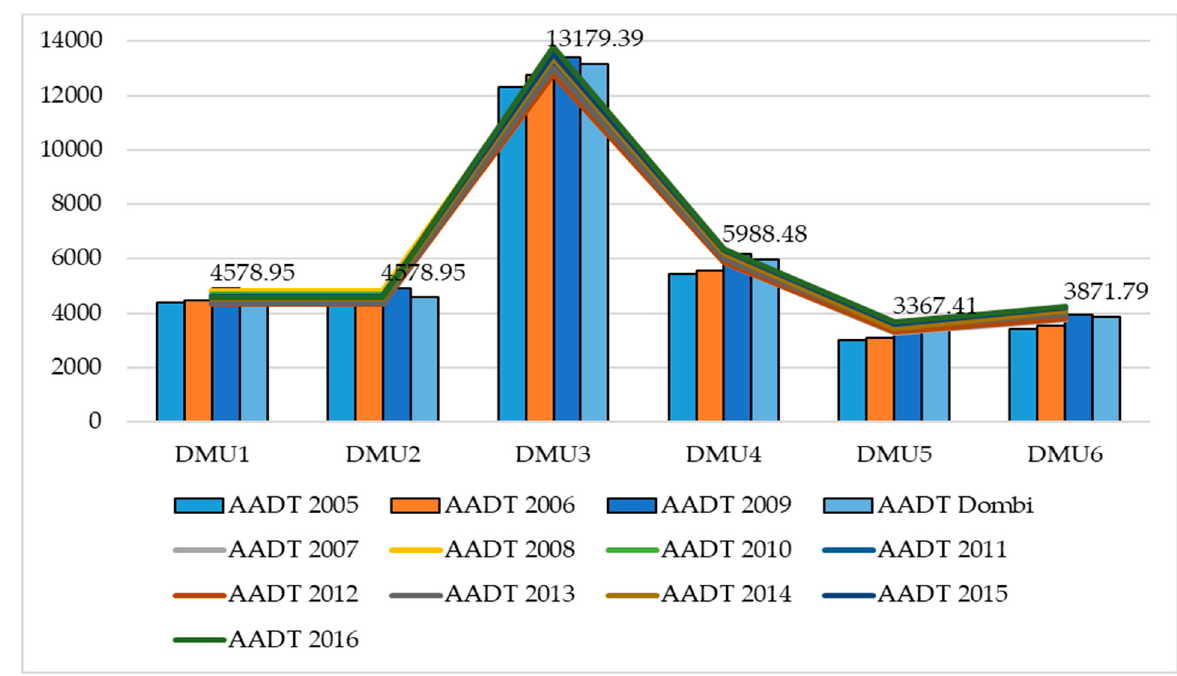
Figure 3. AADT for the period 2005–2016.